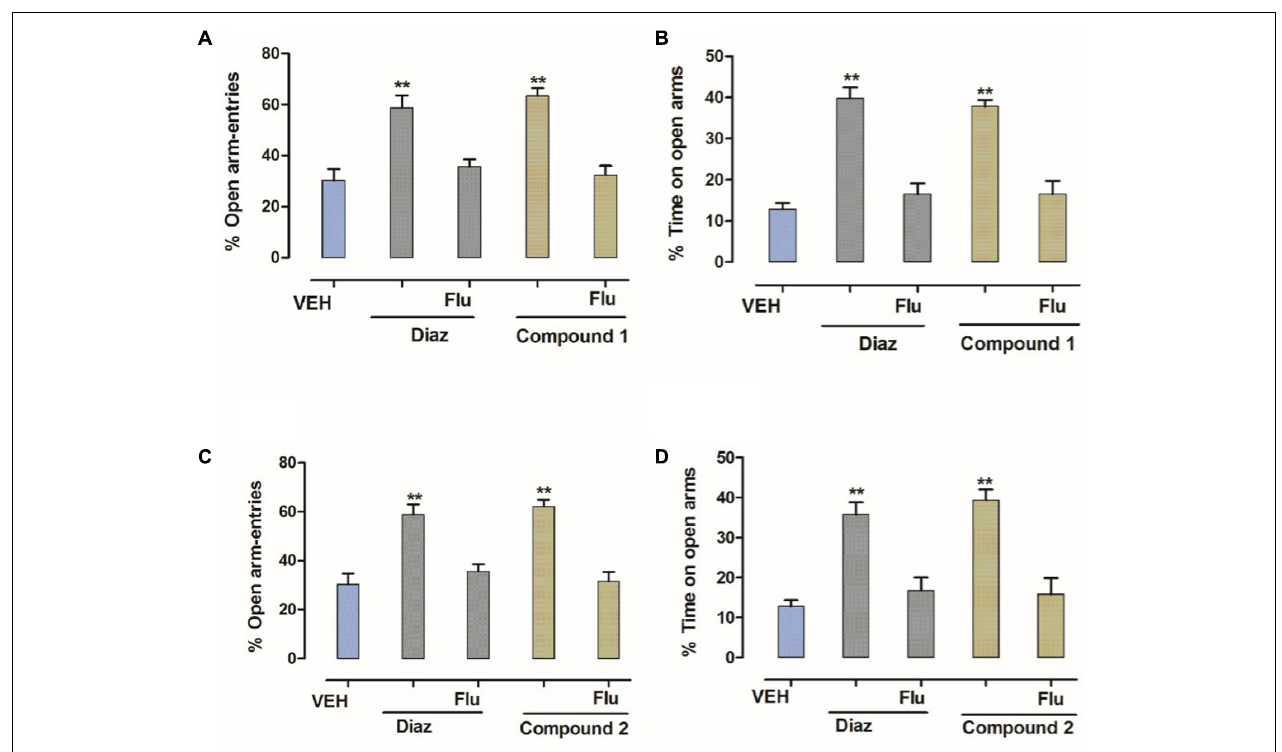
FIGURE 4 | Effect of flumazenil on the anxiolytic activity of compounds 1 and 2 in the EPM. (A) % entries in open arms, (B) % time spent in open arms registered over a session of 5 min, after 20 min of an i.p. injection of vehicle, diazepam (1 mg/kg), and compound 1 (10 mg/kg), (C) % entries in open arms, (D) % time spent in open arms registered over a session of 5 min, after 20 min of an i.p. injection of vehicle, diazepam (1 mg/kg), and compound 2 (10 mg/kg) in the presence of flumazenil (2.5 mg/kg). Columns express mean ± SEM ( n = 6/group), n = 6 per group. ∗∗ P < 0.01, compared with vehicle control group using one-way ANOVA post-Dunnett’s test. Co-administration of flumazenil (2.5 mg/kg) blocked the anti-anxiety action of compounds 1 and 2 (10 mg/kg showing the anxiolytic effect is mediated via the benzodiazepine